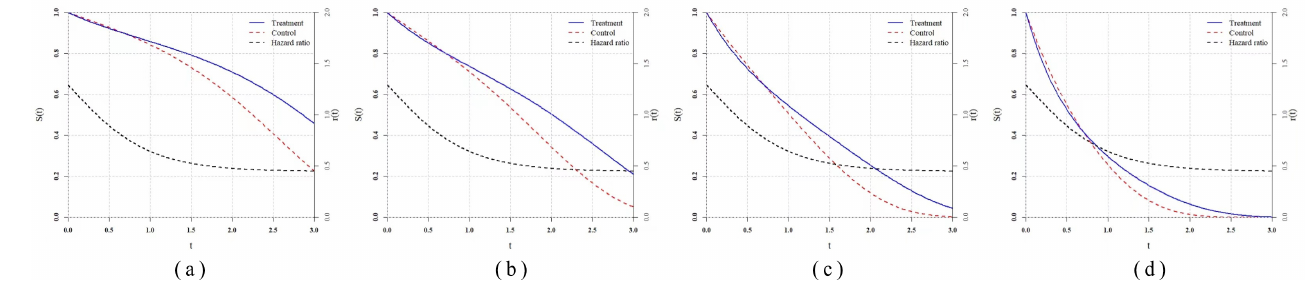
Figure 3. Survival curves with CH function family with parameters settings: ρ = 2, θ C = − 0.4, θ T = 0.4 ( a ) γ = 0.05, ( b ) γ = 0.1, ( c ) γ = 0.2, ( d ) γ =